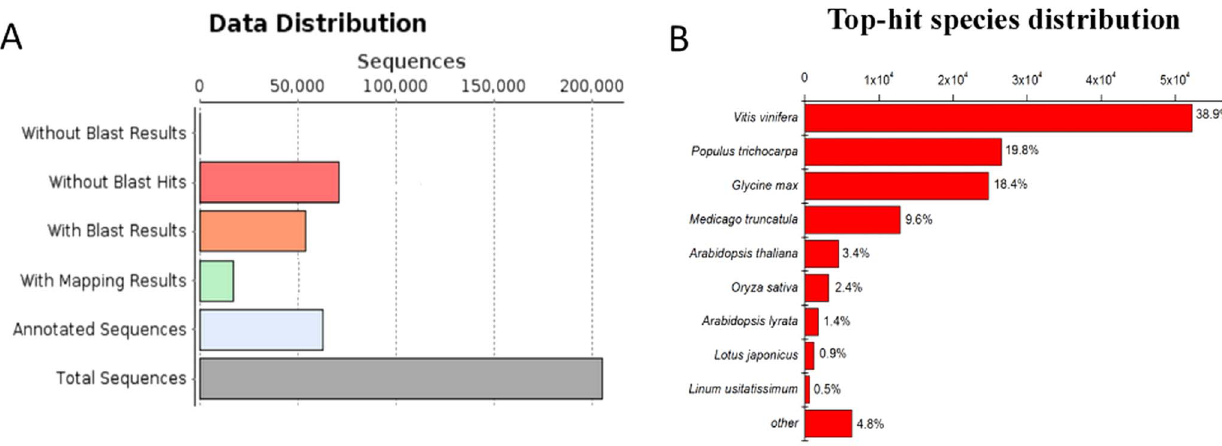
Figure 4. Distribution of the BLASTx results (A) and the top-hit species distribution of the E.dunnii transcriptome (B). A total of 205,325 contigs $ 300 bp in length were used for the sequence similarity searches, and 134,358 contigs produced BLASTx results. All of the contigs with BLASTx results were used for the species distribution analysis. Overall, 52,265 (38.9%), 26,602 (19.8%) and 24,721 (18.4%) contigs showed strong similarity to Vitis vinifera , Populus and Glycine max , but only 265 contigs (0.2%) shared the highest homology with Eucalyptus.